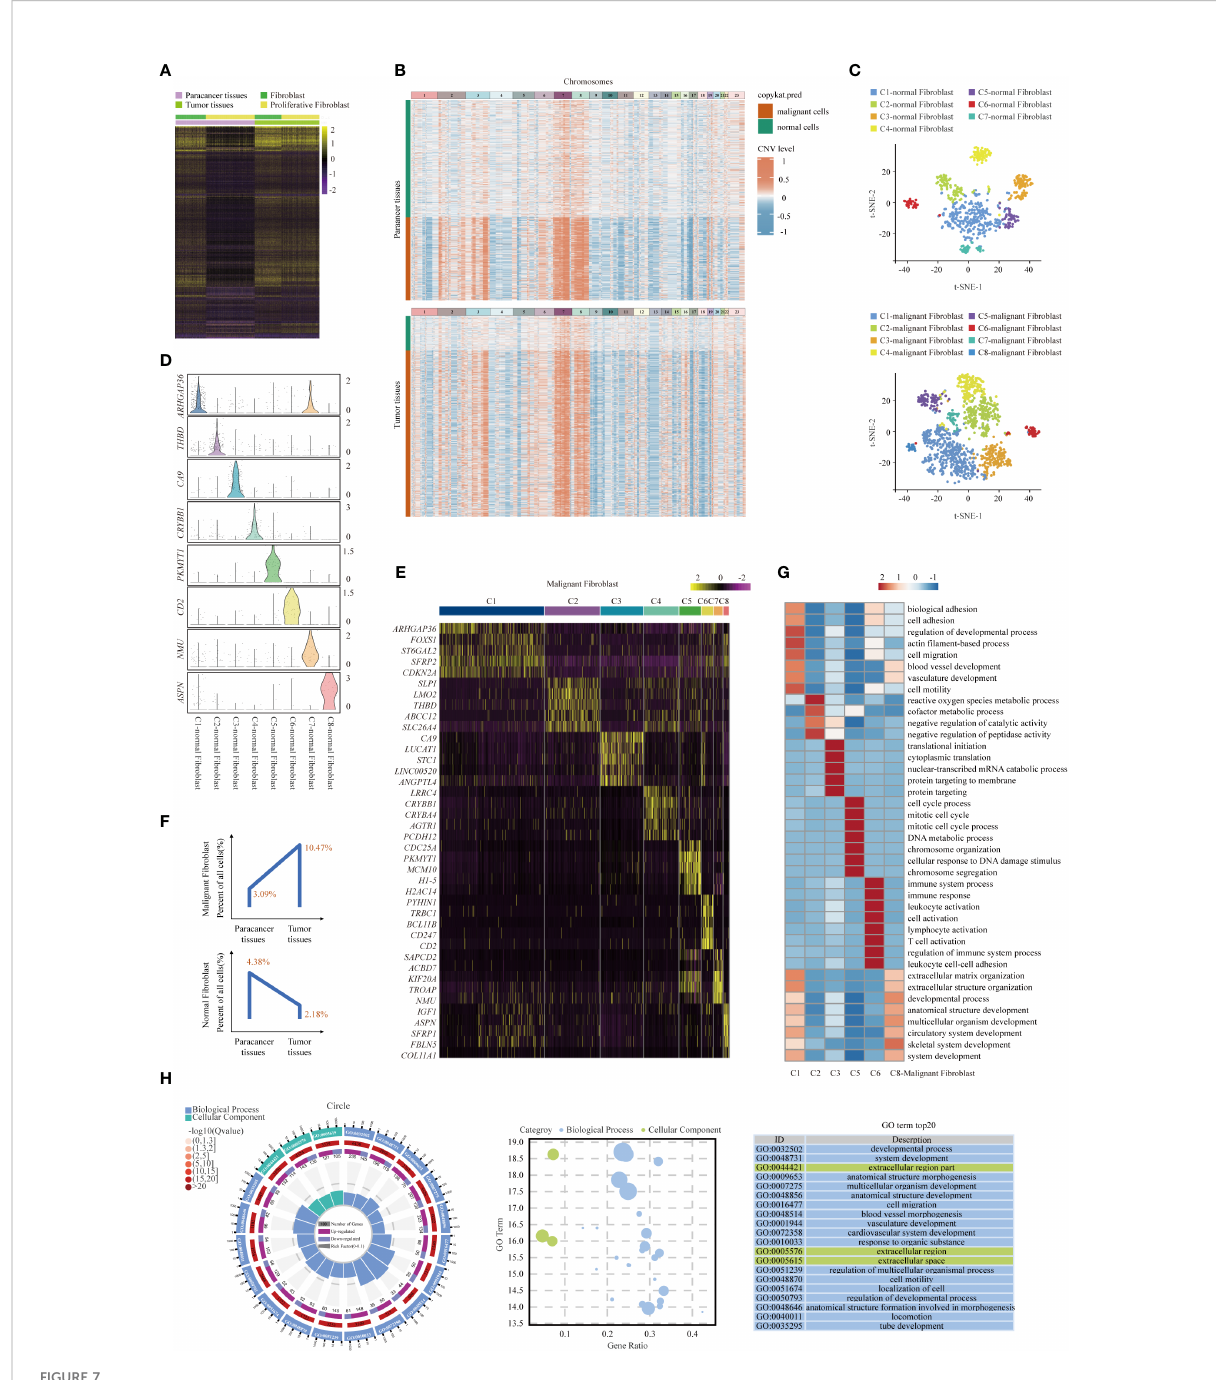
FIGURE 7 Gene expression heterogeneity of fi broblast subsets was identi fi ed in the SUPS. (A) DEGs of fi broblasts in tumor tissues vs paracancer tissues in SUPS were analyzed. (B) Clustered heat map of 2395 scRNA-seq copy number pro fi les estimated by CopyKAT. Fibroblasts were identi fi ed by CopyKAT and divided into malignant fi broblasts and normal fi broblasts. (C) t-SNE plot showing the seven main subsets of normal fi broblasts and the eight main subsets of malignant fi broblasts. (D, E) Violin plot and Heatmap showing speci fi c marker genes in each malignant fi broblasts cluster. (F) The percentages of malignant/normal fi broblasts in paracancer tissues and tumor tissues. (G) Functional enrichment analysis of upregulated genes in each malignant fi broblasts cluster was performed with GO analysis. (H) GO term analysis of DEGs in malignant fi broblasts of tumor tissues versus paracancer tissues was